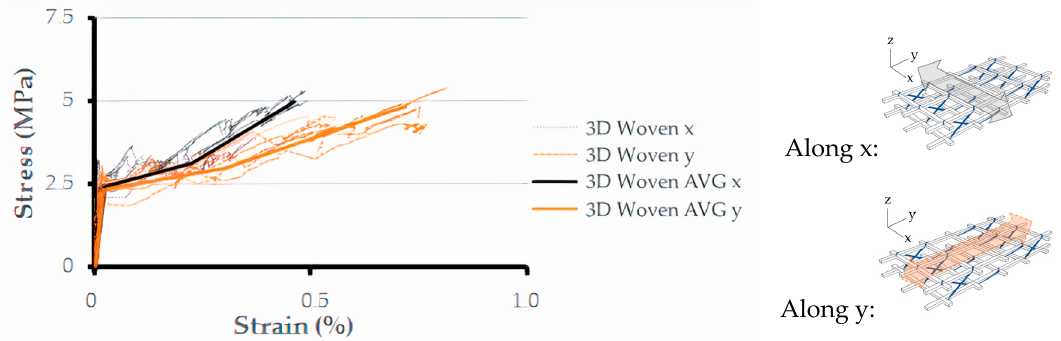
Figure 12. All tensile experimental curves in x- and y-direction for the woven 3D TRC layup, as well as averaged curves. Table 5. Averaged tensile experimental parameters for the woven 3D TRC layup. Woven 3D TRC, along x, V f = 1.49%